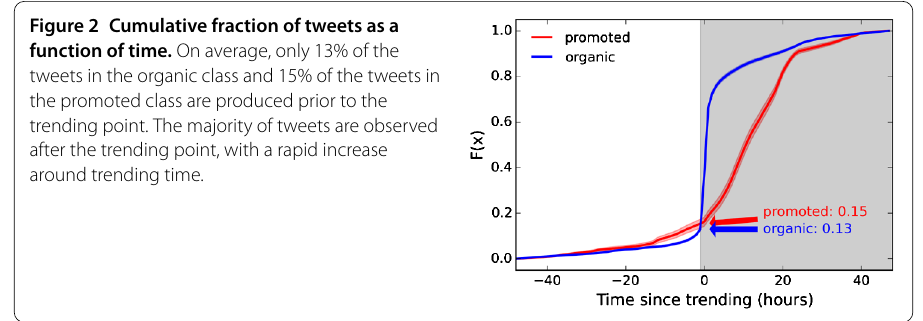
Figure 2 Cumulative fraction of tweets as a function of time. On average, only 13% of the tweets in the organic class and 15% of the tweets in the promoted class are produced prior to the trending point. The majority of tweets are observed after the trending point, with a rapid increase around trending